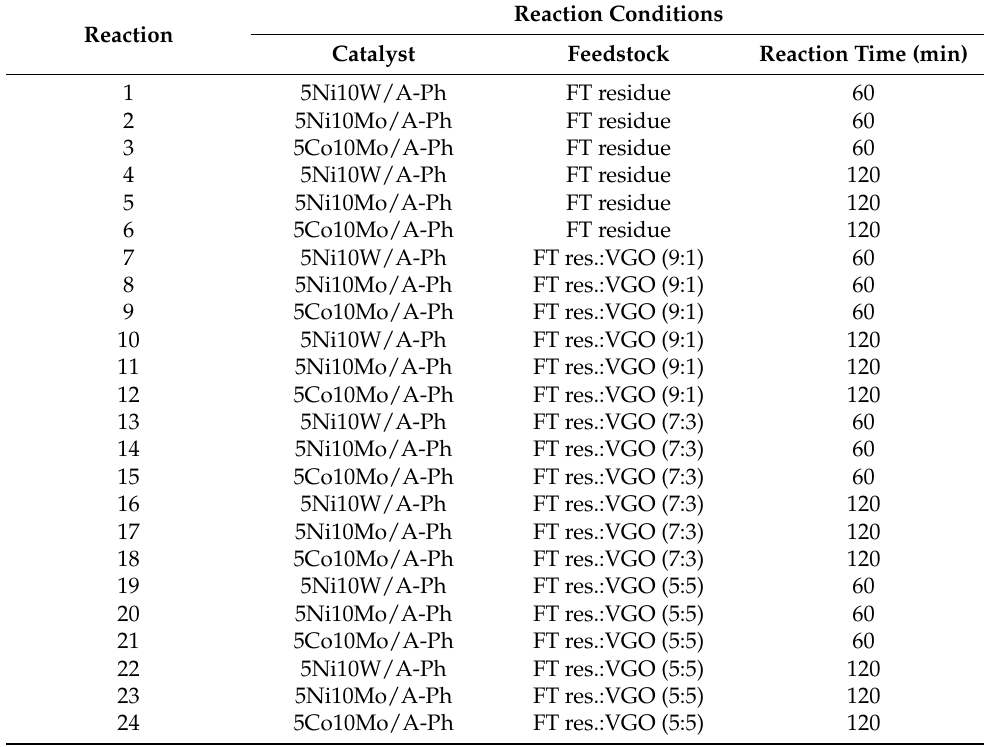
Table 7. Different reaction conditions for the hydrocracking